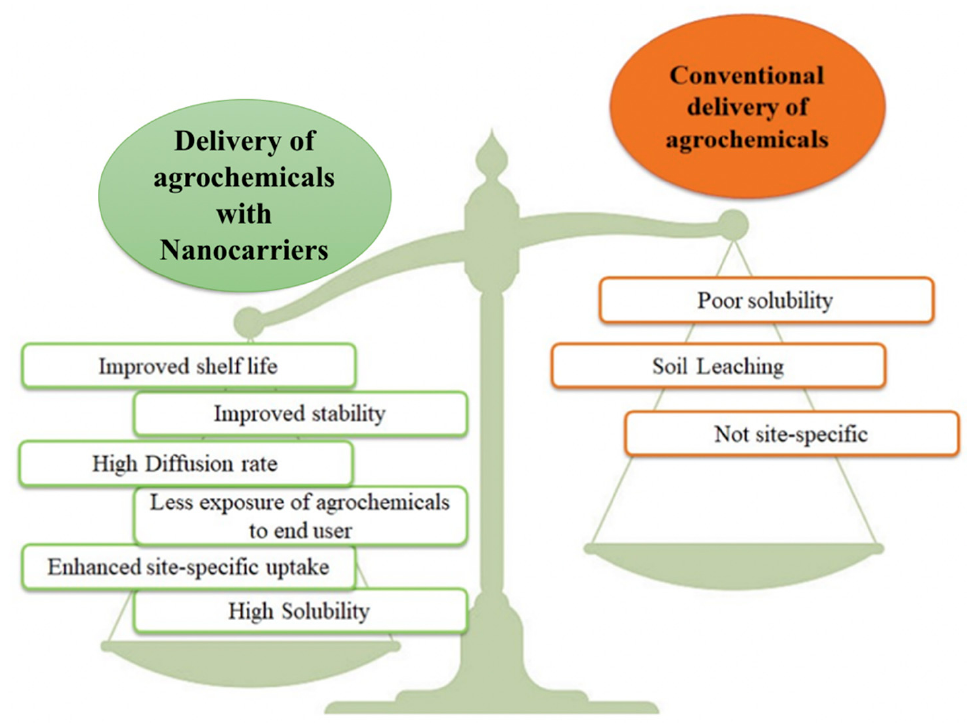
Figure 1. Advantages of delivery of agrochemicals using nanocarriers over conventional